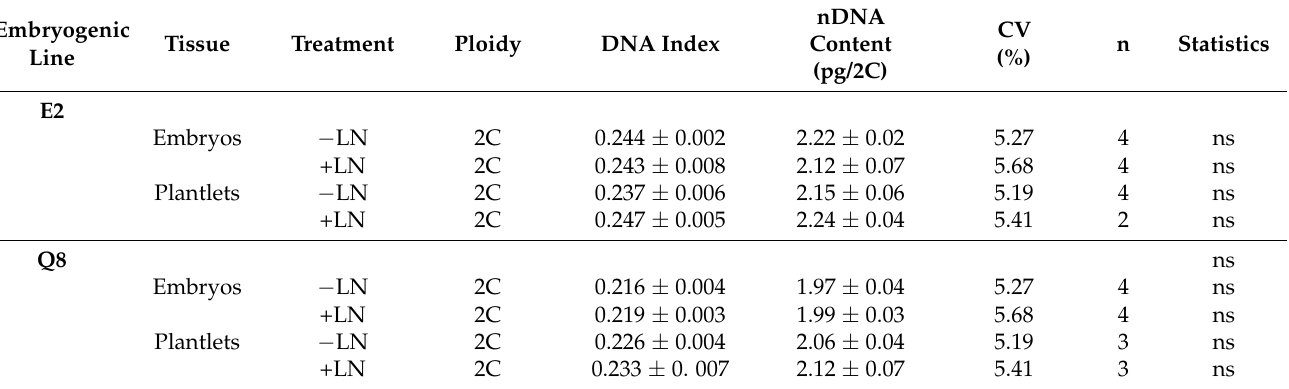
Table 5. Nuclear DNA content (nDNA) of cryopreserved (+LN) and non-cryopreserved ( − LN) embryos and plantlets regenerated from the corresponding embryogenic lines (E2 and Q8) of Quercus ilex (mean ± standard